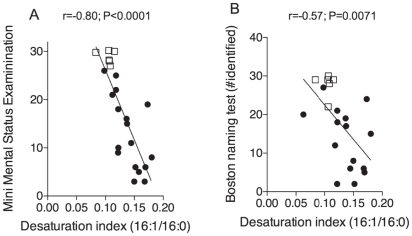
Correlation between brain MUFA levels and cognitive function in subjects with AD and control subjects.Correlation between desaturation index (16:1/16:0) in mid-frontal cortex and most recent neuropsychometric scores from control subjects (open squares) and subjects with AD (closed circles). There were significant correlations between individual desaturation indices and available Mini-Mental State Examination scores (Panel A) and Boston Naming Test scores (Panel B). Partial correlation analysis after adjustment for age, gender and post mortem interval.